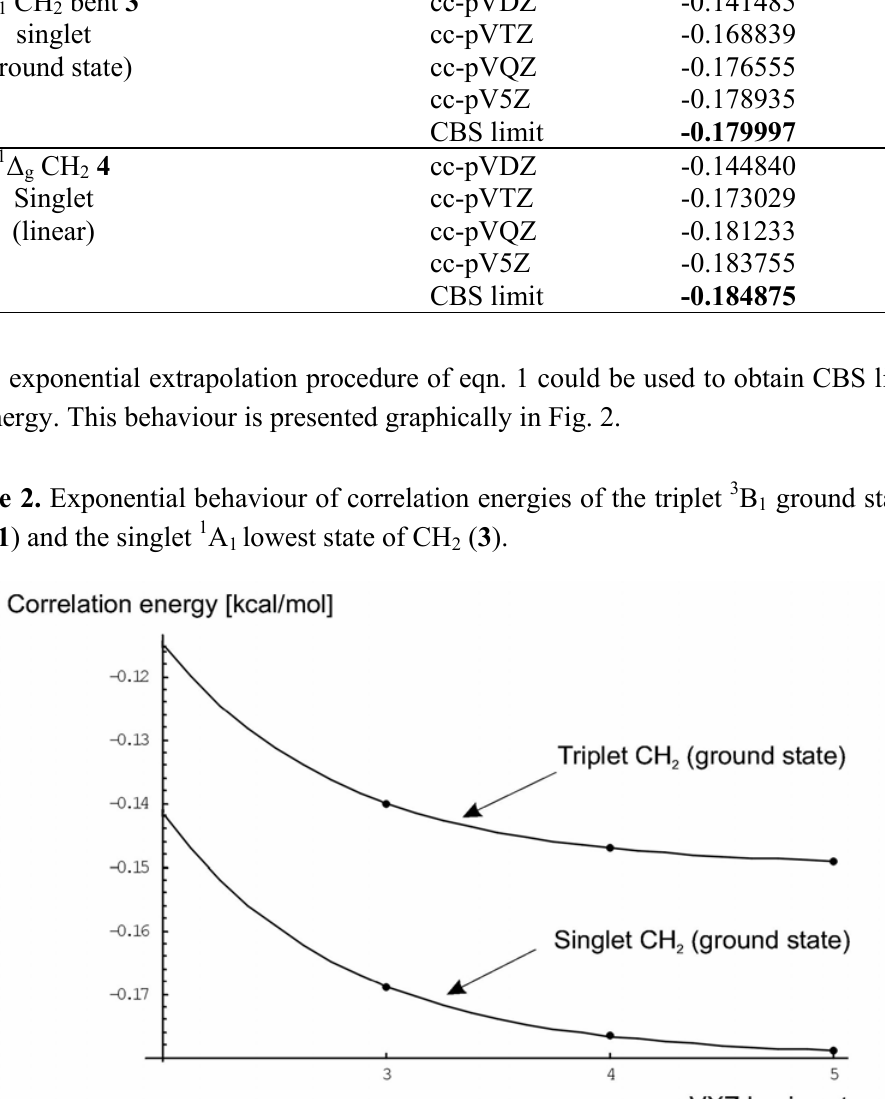
ground state of 1